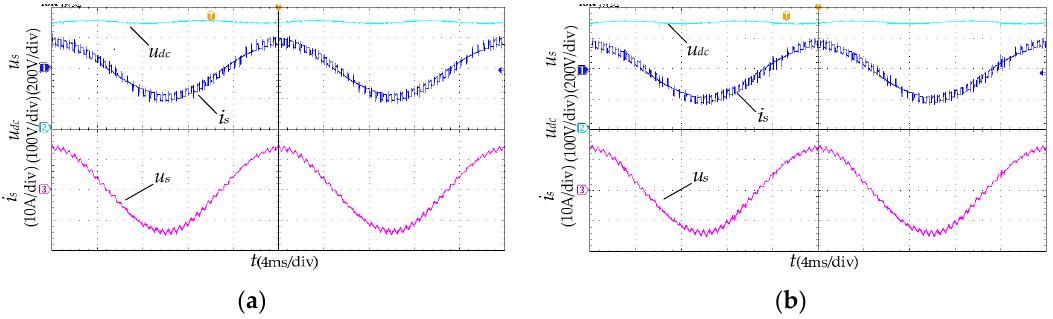
Figure 15. Steady-state experimental waveforms: the grid voltage u s , output voltage u dc and grid current i s , ( a ) saturation control, THD = 4.76%; ( b ) all period desaturation control, t desat = 50 μ s, t lock = 3 μ s, THD = 4.60%.